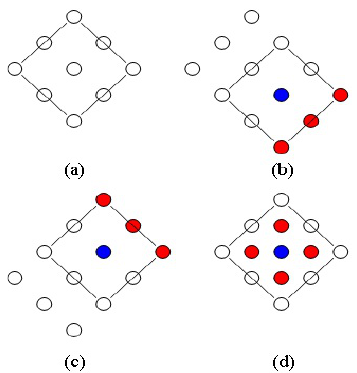
Figure 3. Diamond search